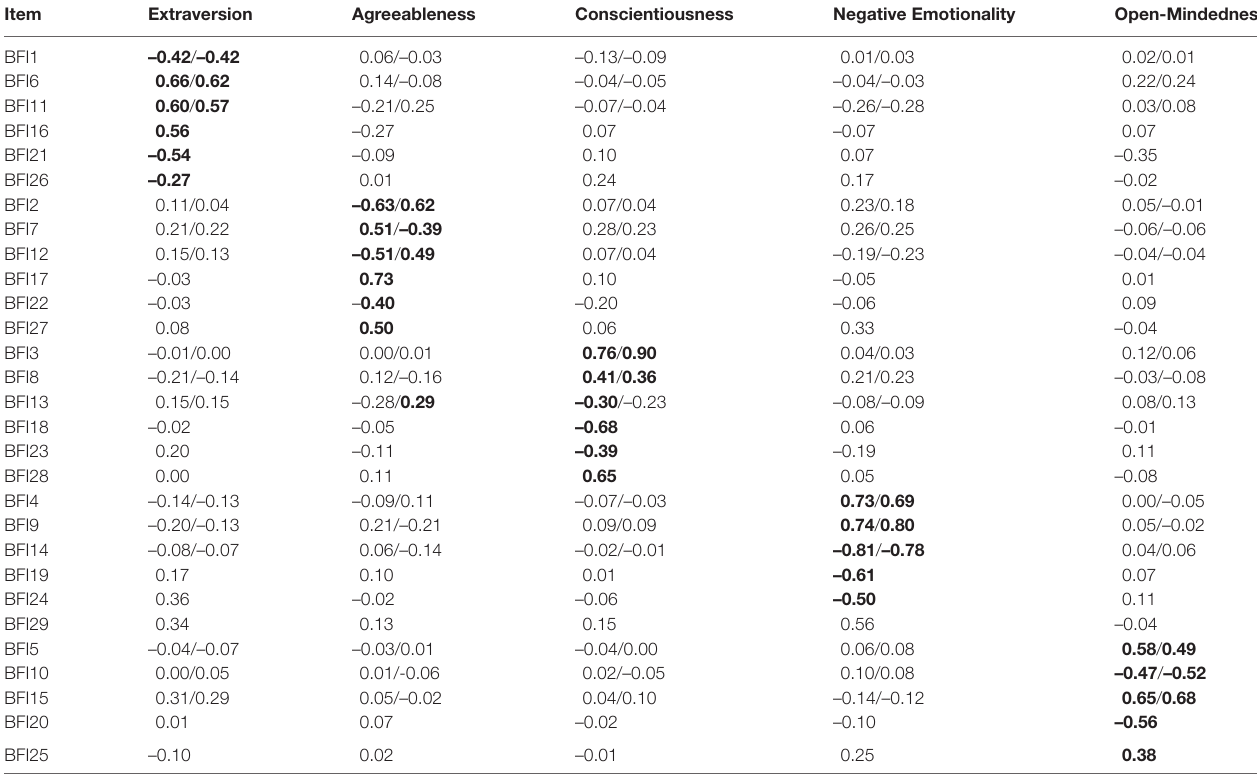
TABLE 9 | Factor loadings from RI-EFA of item scores from the BFI-2-S and BFI-2-XS.